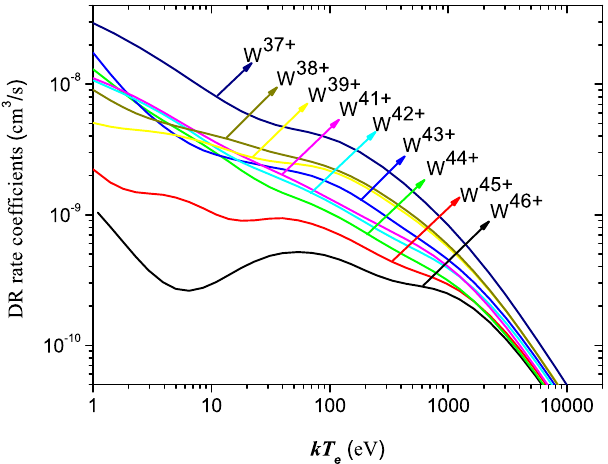
Figure 7. The presently calculated total DR rate coefficients of W 46+ –W 37+ ions as a function of electron temperature kT . e Fitting parameters for the presently calculated total DR rate coefficients of W 46+ –W 37+ ions. Numbers in brackets denote powers of